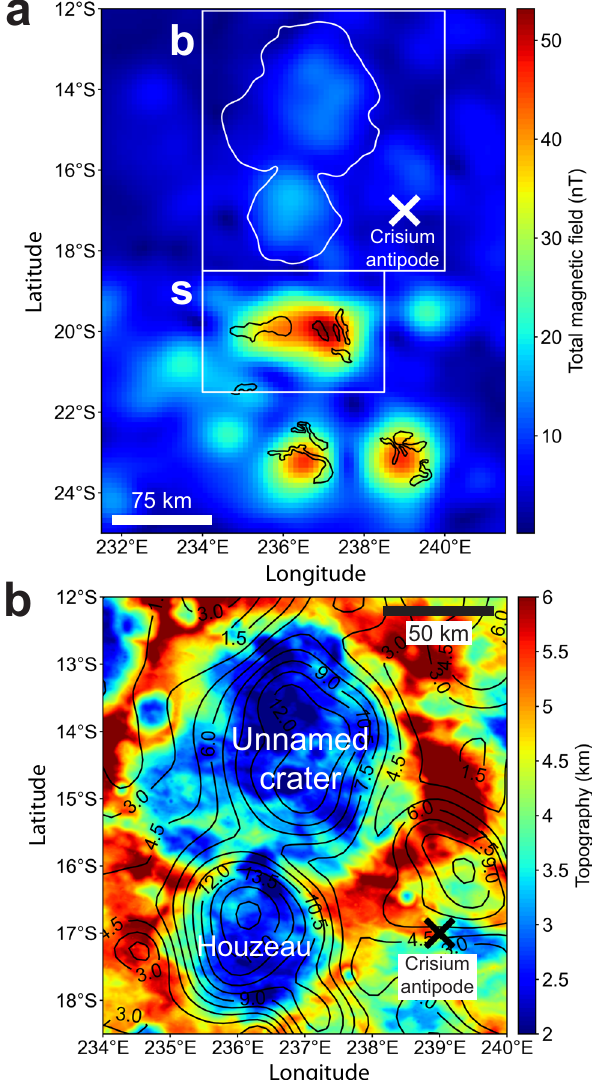
Fig. 1 Family of magnetic anomalies antipodal to the Crisium basin. a Total magnetic fi eld map at 20 km altitude (magnetic data are from the model of Tsunakawa et al. 2015 2 ). Box s shows the region with the strongest observed crustal fi eld on the Moon. Black outlines show locations of bright albedo anomalies known as lunar swirls; white outlines show topography contours of craters in panel b. b Zoom of box b in panel a . Total magnetic fi eld contours (black lines) over topography (topography data are from Smith et al. 2010 65 ). Field contours follow the crater topography in Houzeau crater, and in the eastern half of the unnamed crater, suggesting crater fi ll deposits are the source of the magnetized material. The contours are from 1.5 nT to 18 nT, in 1.5 nT intervals. Topography is saturated at 2 and 6 km to highlight crater rim